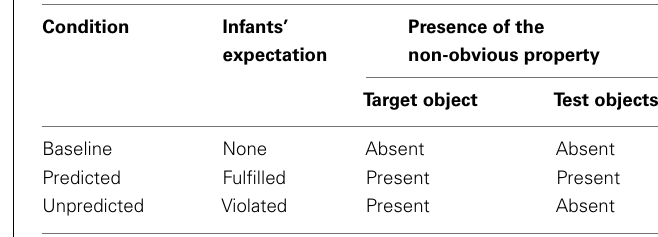
Table 1 | Overview of the three within-subject